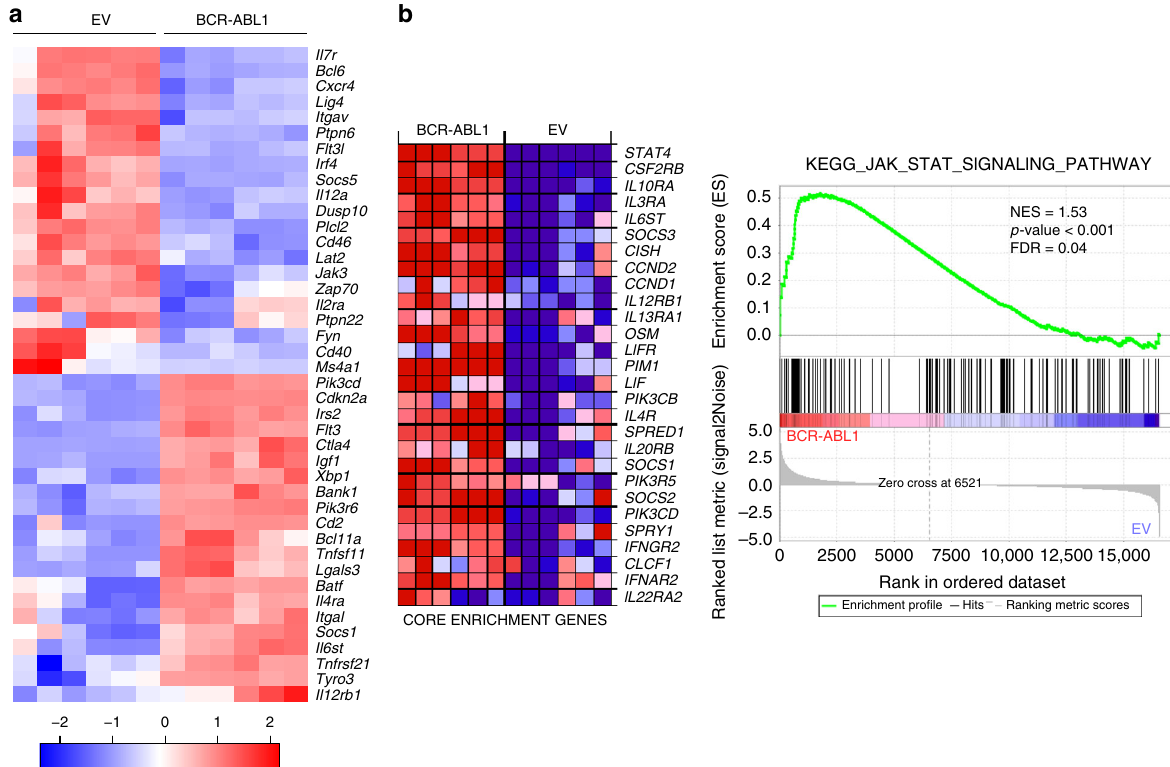
Fig. 1 Gene expression pro fi les of BCR-ABL1-transformed cells. Bone marrow (BM)-derived pre-B cells isolated from two WT mice were used to generate six independent BCR-ABL1-transformed cell lines or six control cell lines expressing empty vector (EV). For expression pro fi ling, RNA was isolated using ReliaPrep ™ RNA Miniprep System (MM). All samples were subjected to RNA quality control test before the RNA-seq was applied. a Heatmap representation of selected genes related to cytokine receptor signaling from the previously speci fi ed GOs (see Supplementary Data 1) in BCR-ABL1- transformed cells compared with the EV-transduced cells. Samples are represented in columns while rows show genes. An average linking method based on Pearson correlation distance metric was applied to cluster rows and columns. b Gene Set Enrichment Analysis (GSEA) showing upregulation of gene set belonging to the JAK-STAT signaling pathway in BCR-ABL1 group. Heatmap representation (left) of the top 28 deregulated genes (core enrichment genes) in BCR-ABL1 versus EV-transduced samples (Blue: downregulated, Red: upregulated, NES normalized enrichment score, FDR false discovery rate). A two- sided signal-to-noise metric was used to rank the genes. For a calculated GSEA nominal p values of 0, we present them as p < 0.001 (otherwise, exact p values are shown). Multiple hypothesis testing correction is represented by the estimated